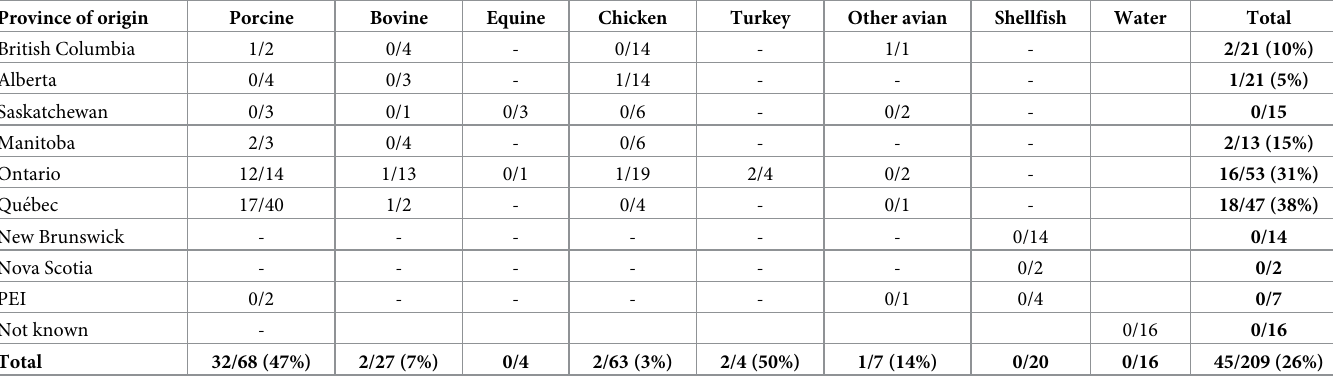
Table 1. Non-human isolates carrying the MREL and/or SGI-4 versus total number of isolates tested, by source and province. Province of